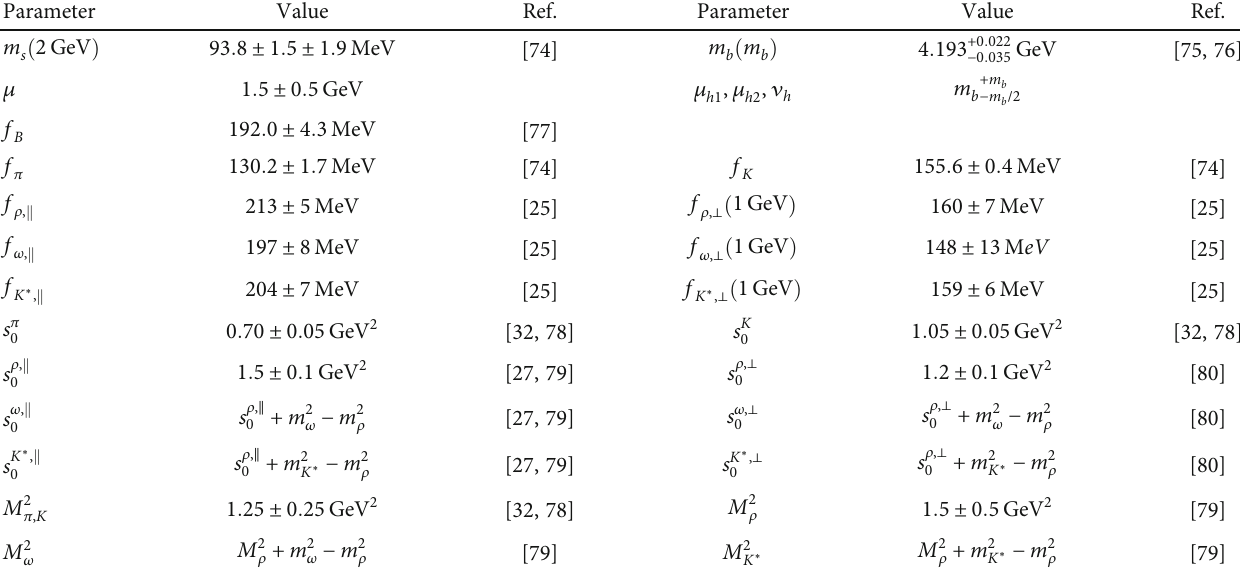
Figure 7: The Borel mass and threshold dependence of the form factor f + Table 1: The numerical values of the various input parameters employed in the theory predictions of the B ⟶ M form factors with B -meson